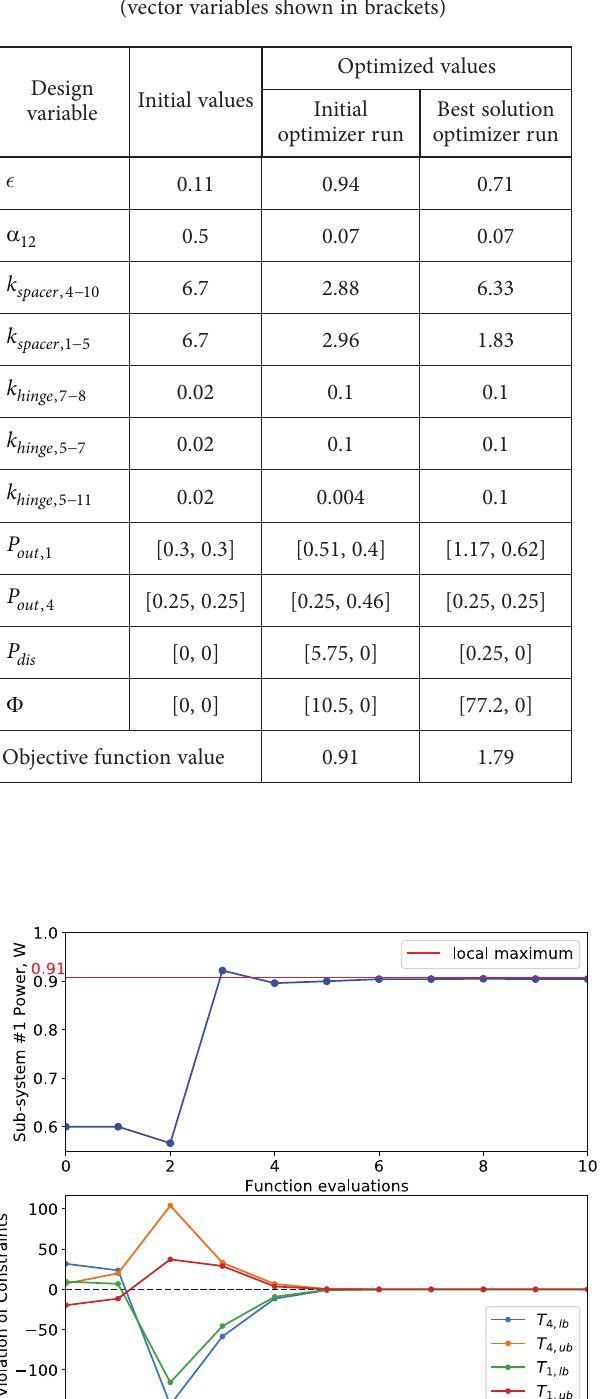
Table 4. Initial and optimized values of design variables (vector variables shown in brackets)